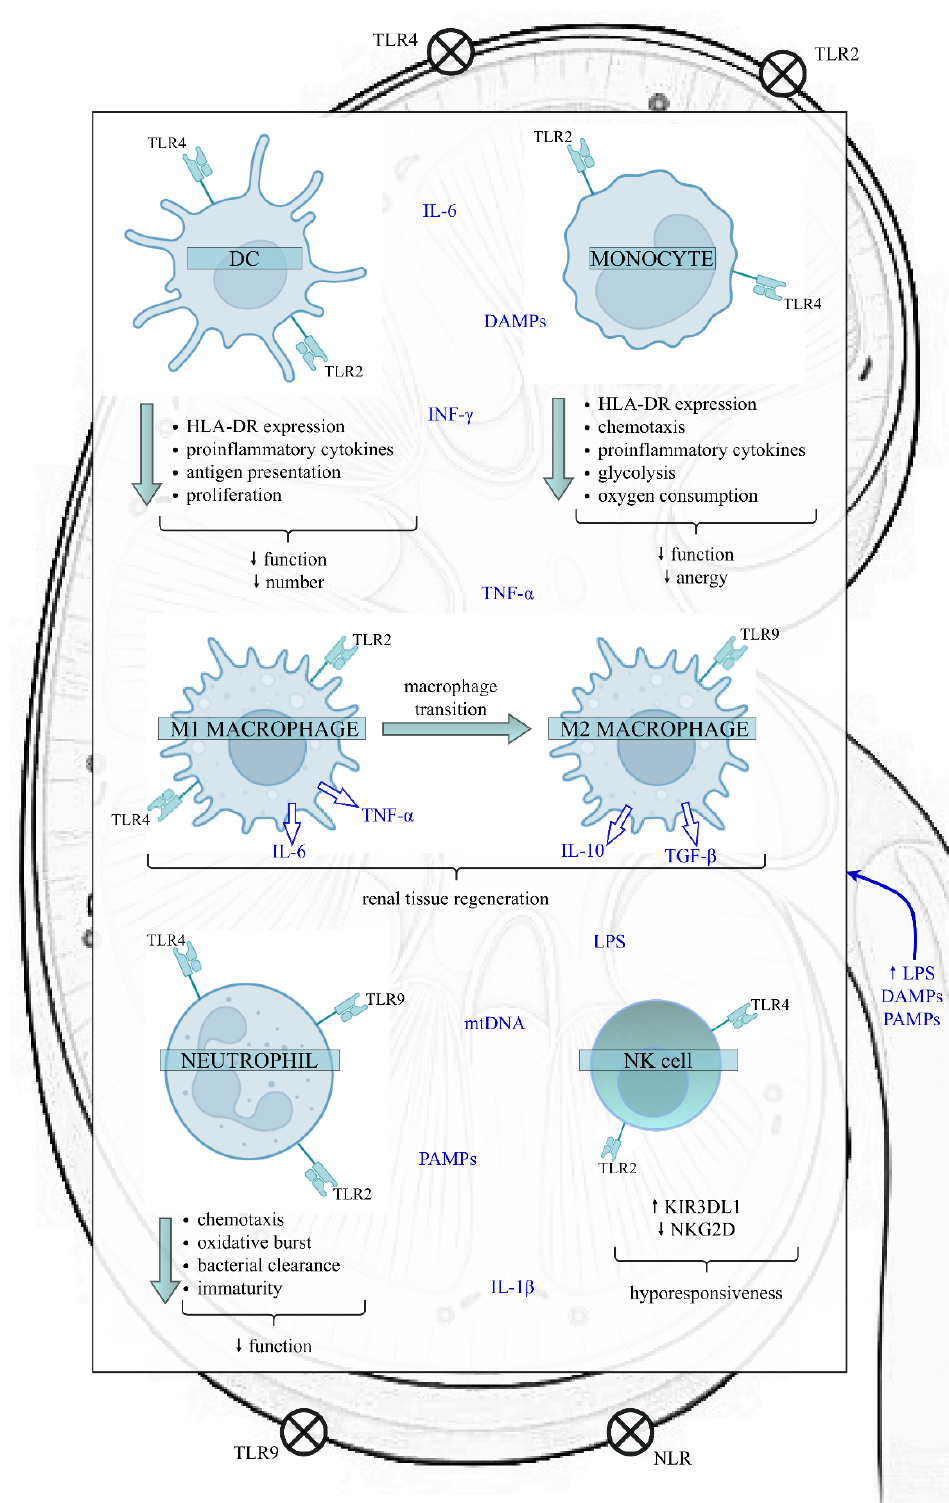
Figure 1. The impact of sepsis on the function of the innate immune cells in the kidney. Sepsis exposes the kidney to a proinflammatory microenvironment, which impairs various kidney structures, like RTECs, Bowman’s capsular epithelium, and glomerular and endothelial cells. In the initial phase of sepsis, LPS, PAMPs and DAMPs bind to TLRs and NLRs present on the surface of both kidney and innate immune cells, initiating a downstream cascade of signals that results in the synthesis and release of proinflammatory cytokines. However, as sepsis continues, the innate immune response is altered. The above alterations include the reduced function and number of DCs,